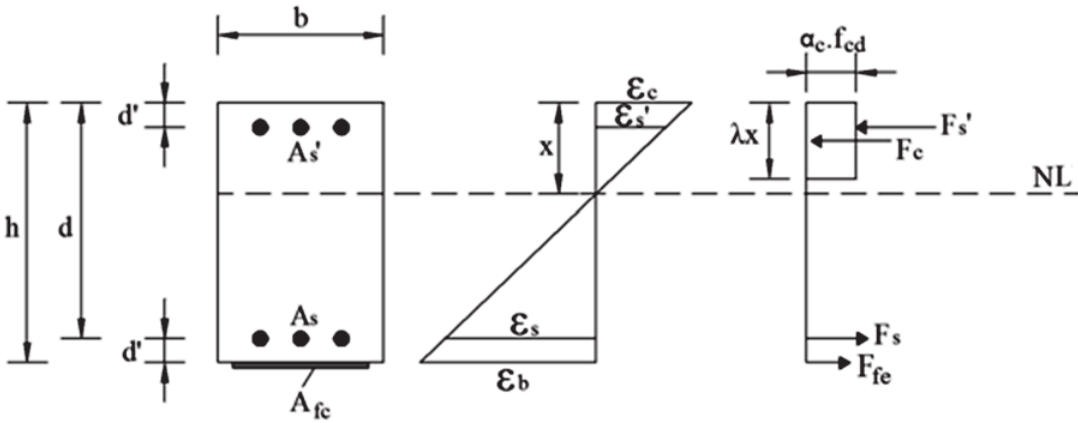
Distribuição de deformações e forças em uma seção reforçada à flexão com